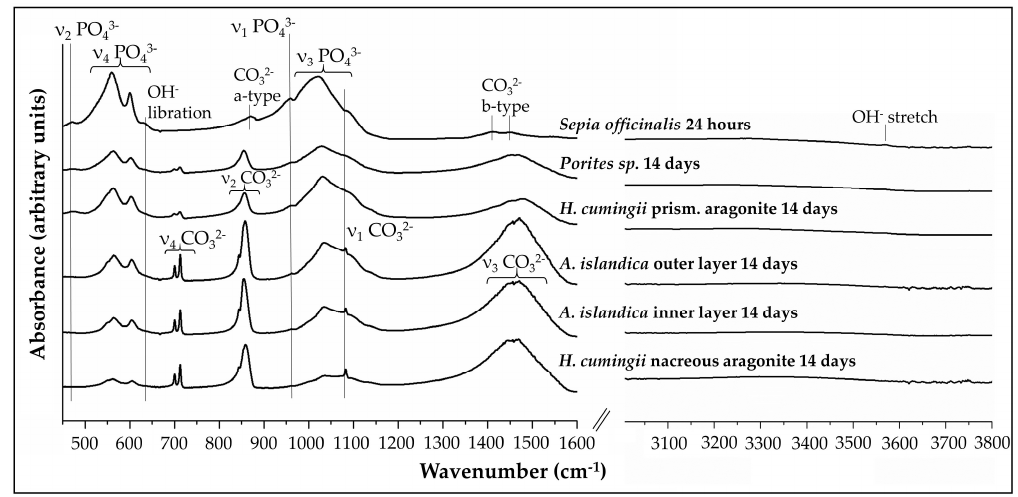
Figure 2. Infrared-spectra (450–1600 cm −1 and 3000–3800 cm −1 ) for Sepia officinalis cuttlebone transformed for 24 h together with IR-spectra for Porites sp. coral aragonite, H. cumingii prismatic aragonite, A. islandica outer and inner shell layer aragonite and H. cumingii nacreous aragonite. Spectra are arranged according to AP content (wt %) determined with XRD and Rietveld analyses. AP content increases from bottom to top spectra.